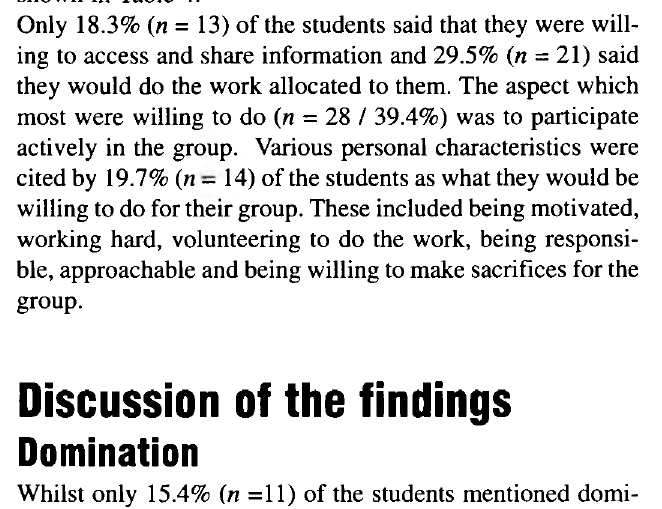
Table 4 : Things willing to do for the group ( n ^ 7 1